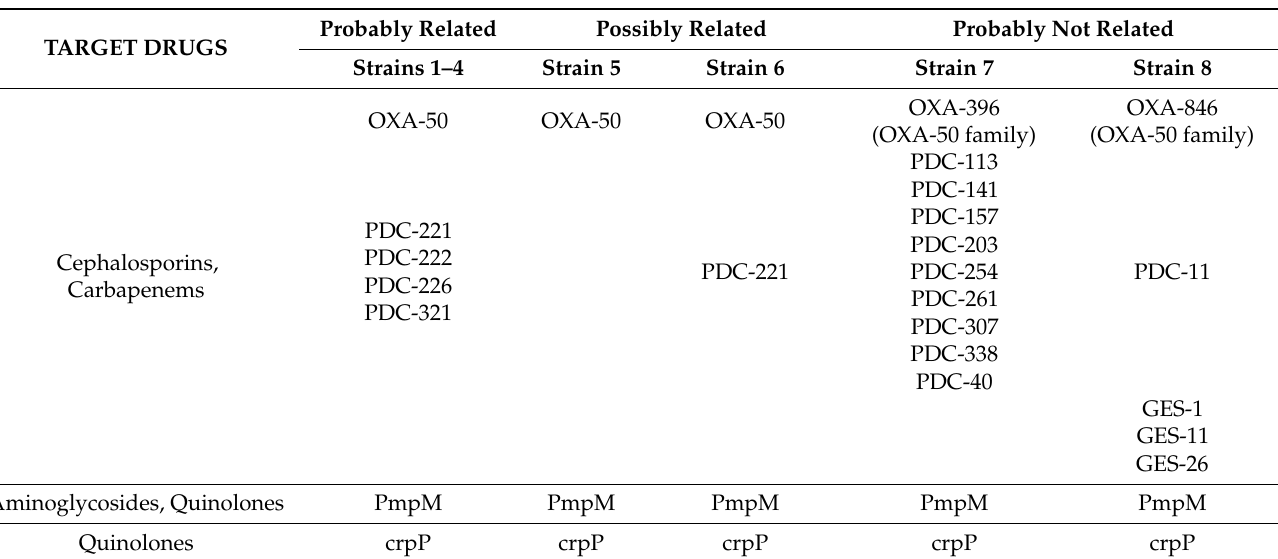
Table 4. The deduced proteins from the resistance genes detected by the WGS analysis in the ST175 MDRPA isolates. The variants that were detected are specified.